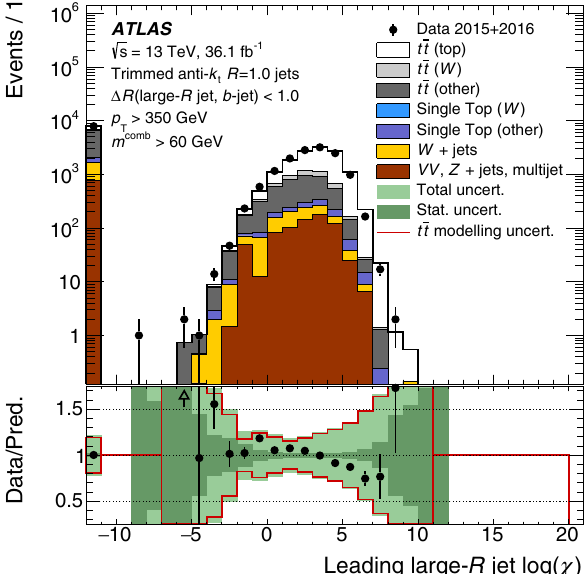
Fig. 13 A comparison of the observed data and predicted MC distribu- tions of the TopoDNN top tagger discriminant for the top-quark event selection in a sample enriched in lepton+jets t ¯ t events. Simulated dis- tributions are normalised to data. The t ¯ t sample is divided into a set of subsamples (e.g. t ¯ t (top)) based on criteria described in Sect. 4.2. In this case, a p T > 450 GeV selection is applied to the large- R jet to specif- ically focus on the kinematic region of interest for which this tagging algorithm was designed, as described in Sect. 5.3. The statistical uncer- tainty of the background prediction (Stat. uncert.) results from limited Monte Carlo statistics as well as the limited size of the data sample used in the data-driven estimation of the multijet background